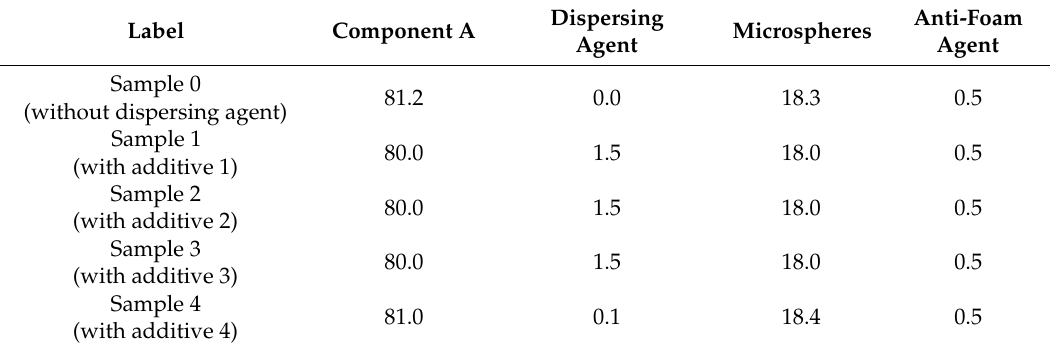
Table 1. Summary of the un-crosslinked sample compositions expressed in w / w %.